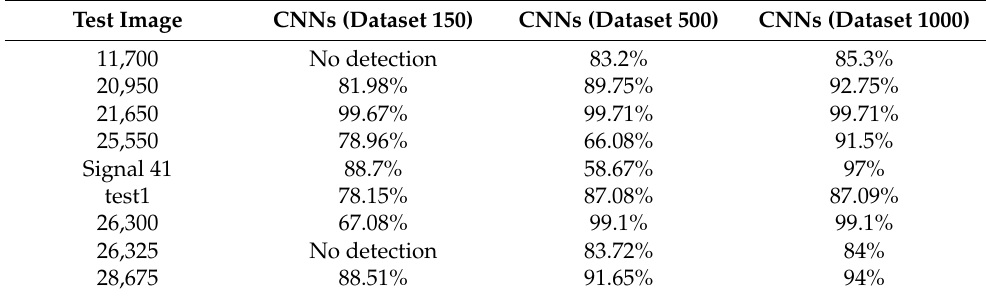
Figure 13. Signal detection—bounding box, class, and system reliability (dataset 500). A comparison was made between the detection reliability of the three neural networks, and the results are shown in Table 1. Table 1. Comparison of the algorithm reliability between CNNs (dataset 150 images), CNNs (dataset 500 images), and CNNs (dataset 1000 images).